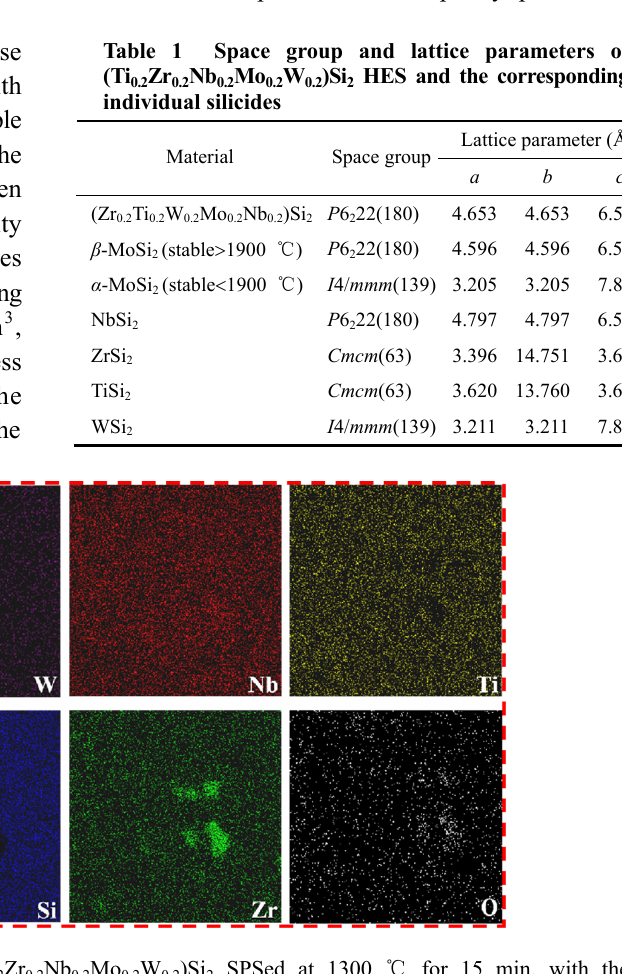
Fig. 1 XRD patterns of the samples SPSed at 900, 1100, and 1300 ℃ for 5 min and 1300 ℃ for 15 min.